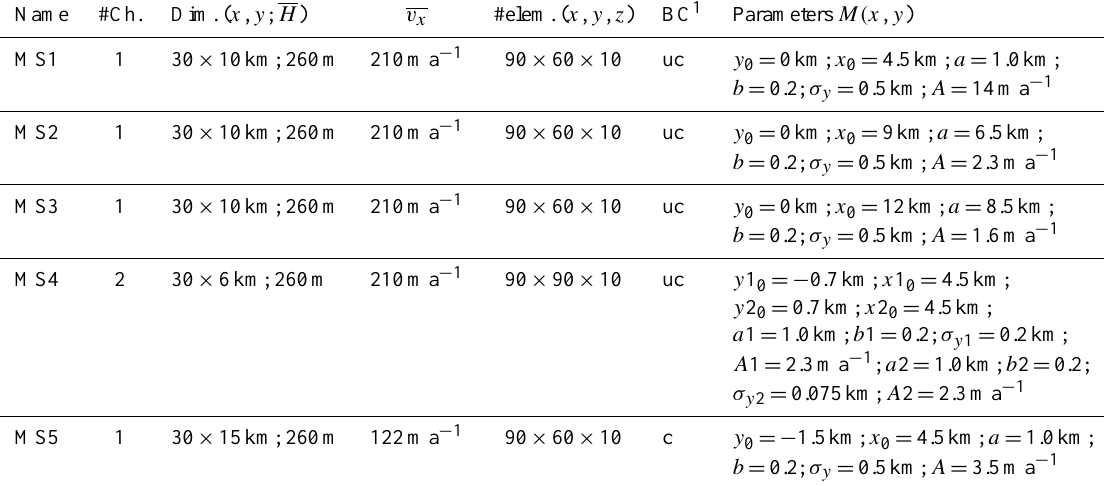
Table 1. Parameters (number of channels (#Ch.), along-flow distance ( x ), across-flow distance ( y ), mean thickness ( H ), mean along-flow velocity ( v x ), number of elements (#elem.), lateral boundary condition (BC)) for the different scenarios MS1–5.